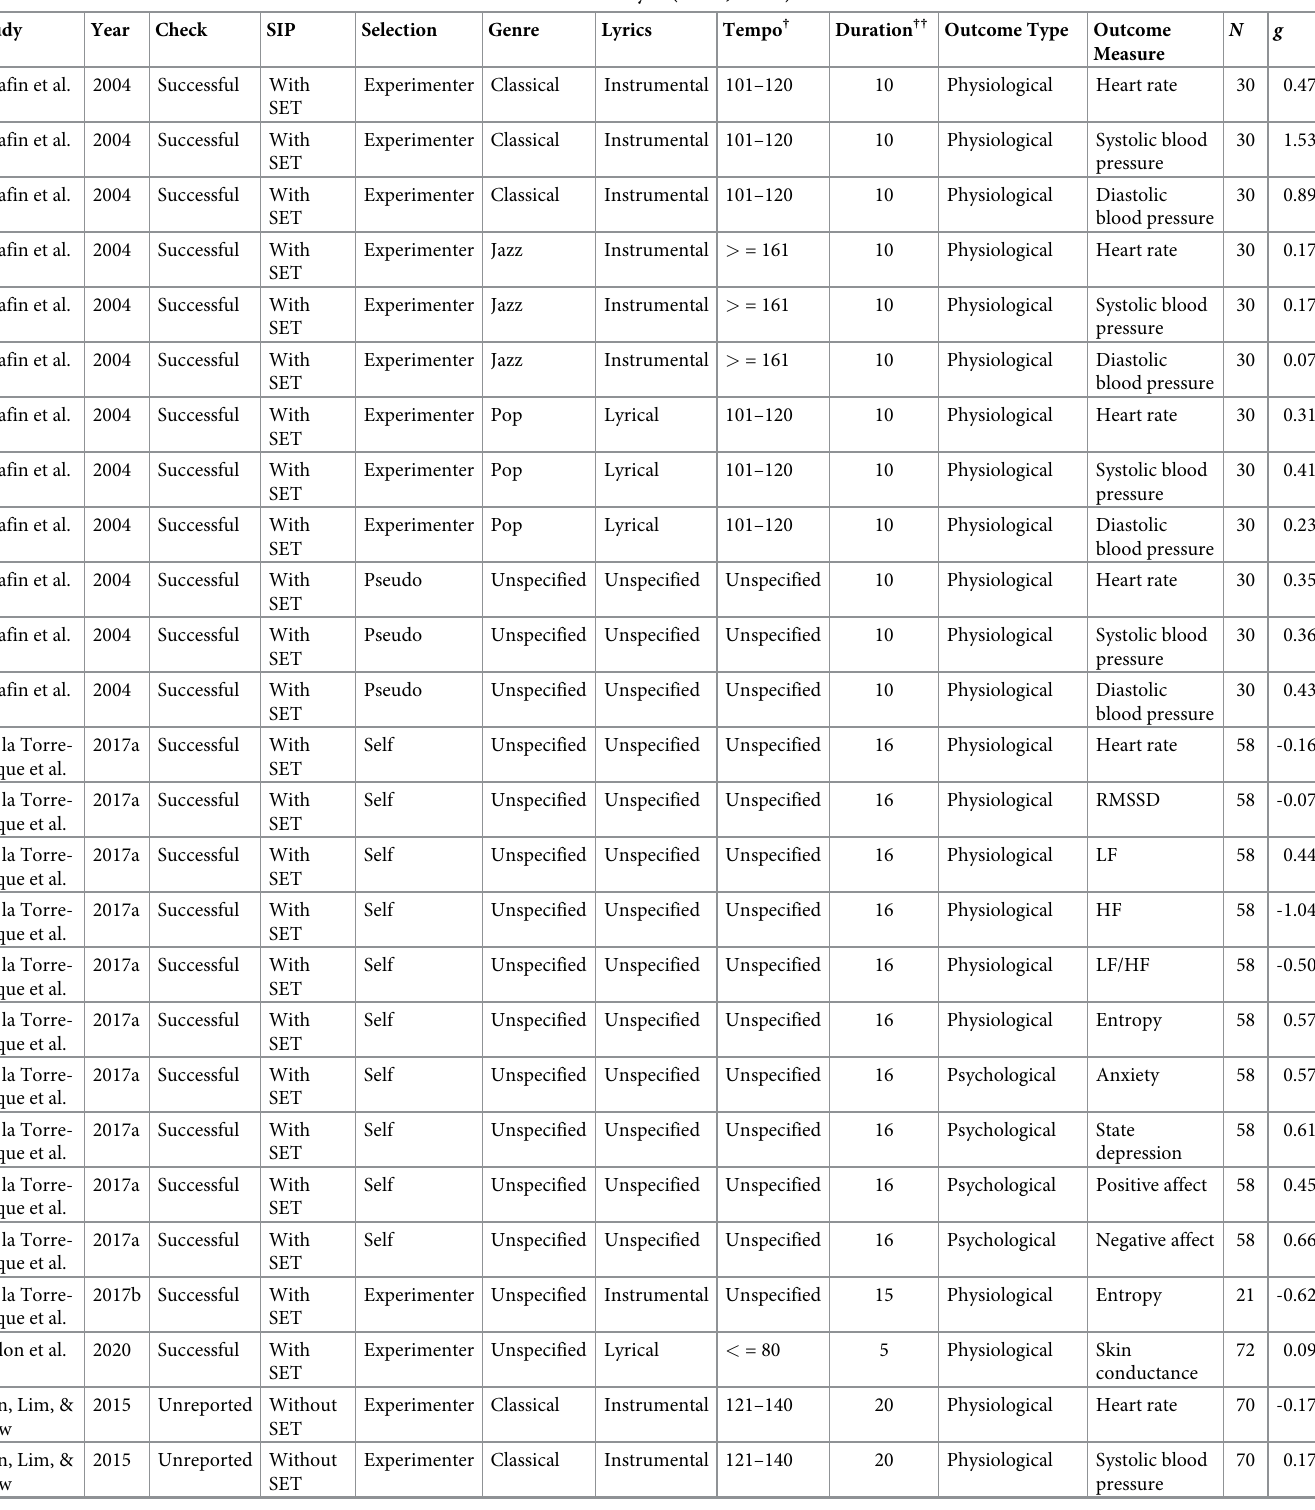
Table 2. Coded information and effect sizes of studies included in the meta-analysis (s = 14; k = 90). Study Year Check SIP Chafin et al. 2004 Chafin et al. 2004 Chafin et al. 2004 Chafin et al. 2004